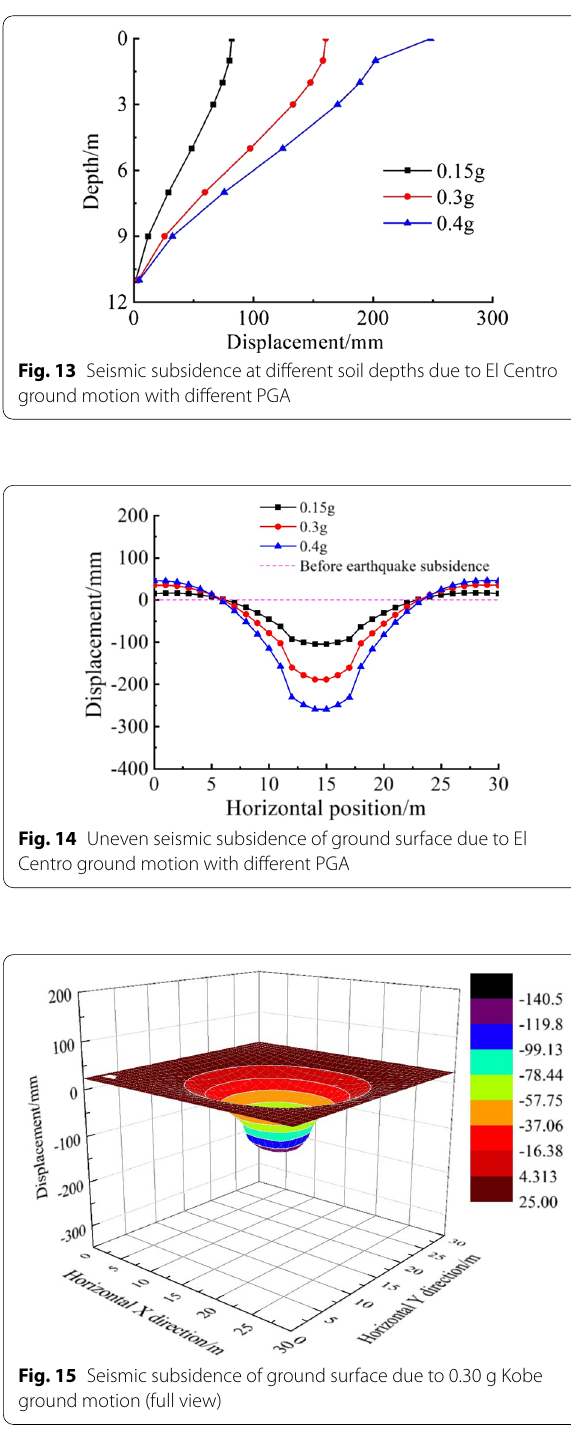
the subsidence adopts a parabolic shape that is symmetri- cally distributed on the low, middle, and high sides with a maximum depression angle of 5.01°. The largest displace- ment was found at the bottom middle of the foundation.